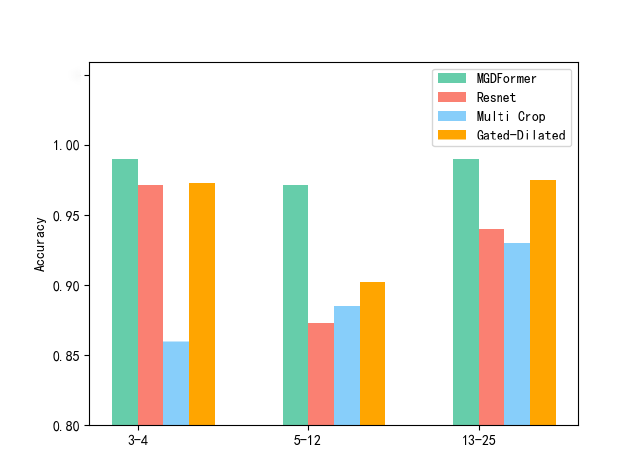
Figure 4. The performance of multiple methods on different size